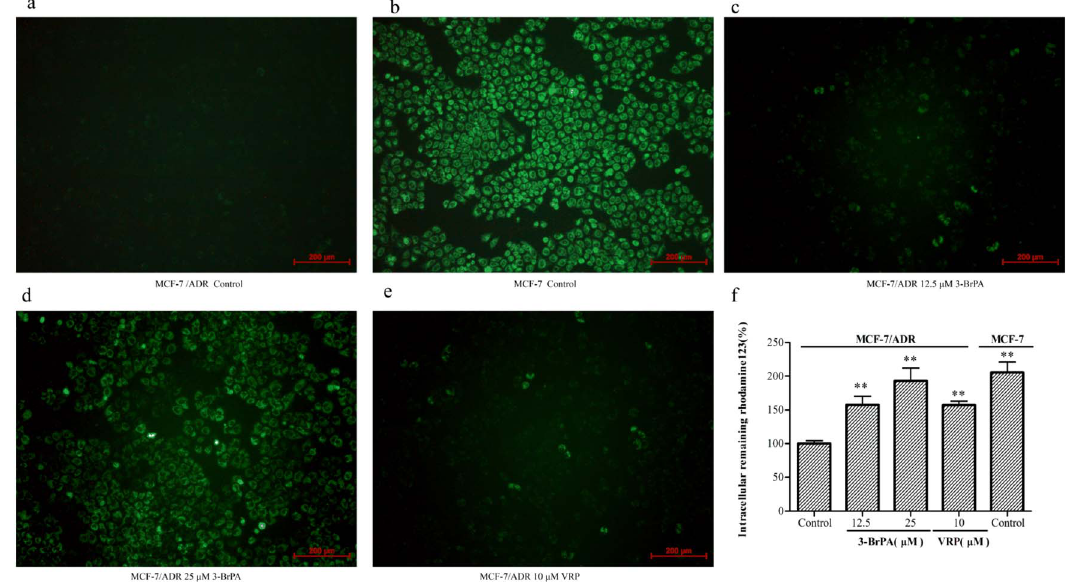
Figure 4. 3-BrPA and VRP increase the accumulation of Rh123 in MCF-7/ADR cells. Cells were treated with 12.5, 25 m M 3-BrPA and 10 mm VRP for 4 h at 37 u C. Then Rh123 (5 m M) was added and incubated in the dark at 37 u C for an additional 1 h. After washing cells three times with cold PBS, images were acquired by a fluorescence microscopy at 488 nm extraction and 535 nm emission wavelength for Rh123. The fluorescence intensity was quantitatively detected by multi-mode microplate reader. a-e: 3-BrPA and VRP increase the accumulation of Rh123 in MCF-7/ADR by fluorescence microscopy f: 3-BrPA and VRP increase the accumulation of Rh123 in MCF-7/ADR by multi-mode microplate reader ** P , 0.05 compared with the